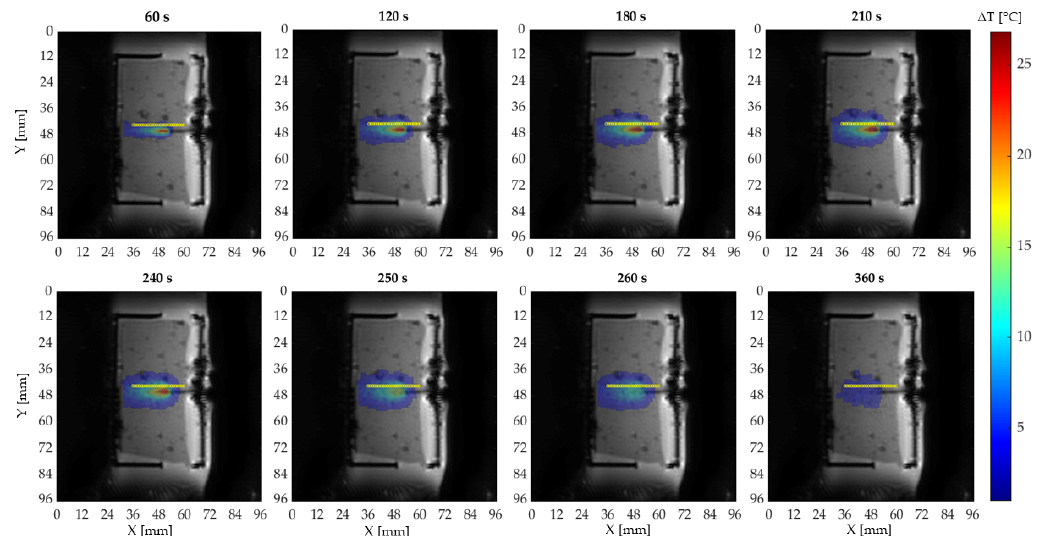
Figure 5. Temperature distribution in eight different time instants: The first five images are acquired during the ablation and the last three during the cooling period. The yellow markers specify the FBGs position.